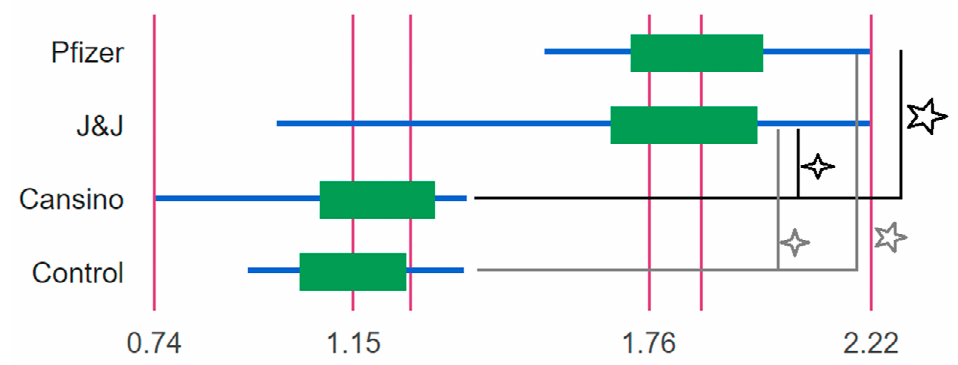
Figure 1. Box plot of the Log10NT50 of the breast milk from mother with different vaccination profiles. All groups were compared with the Kruskal-Wallis test with multiple comparisons. Significant differences (star) were observed in the Log10NT50 between Pfizer, CanSino ( p -value 0.0006), and the control ( p -value 0.01). In addition, significant differences (asterisk) were also observed between J&J, CanSino ( p -value 0.002), and the control group ( p -value 0.01). For each vaccination Log10NT50 profile the maximum, median, and minimum values are shown.